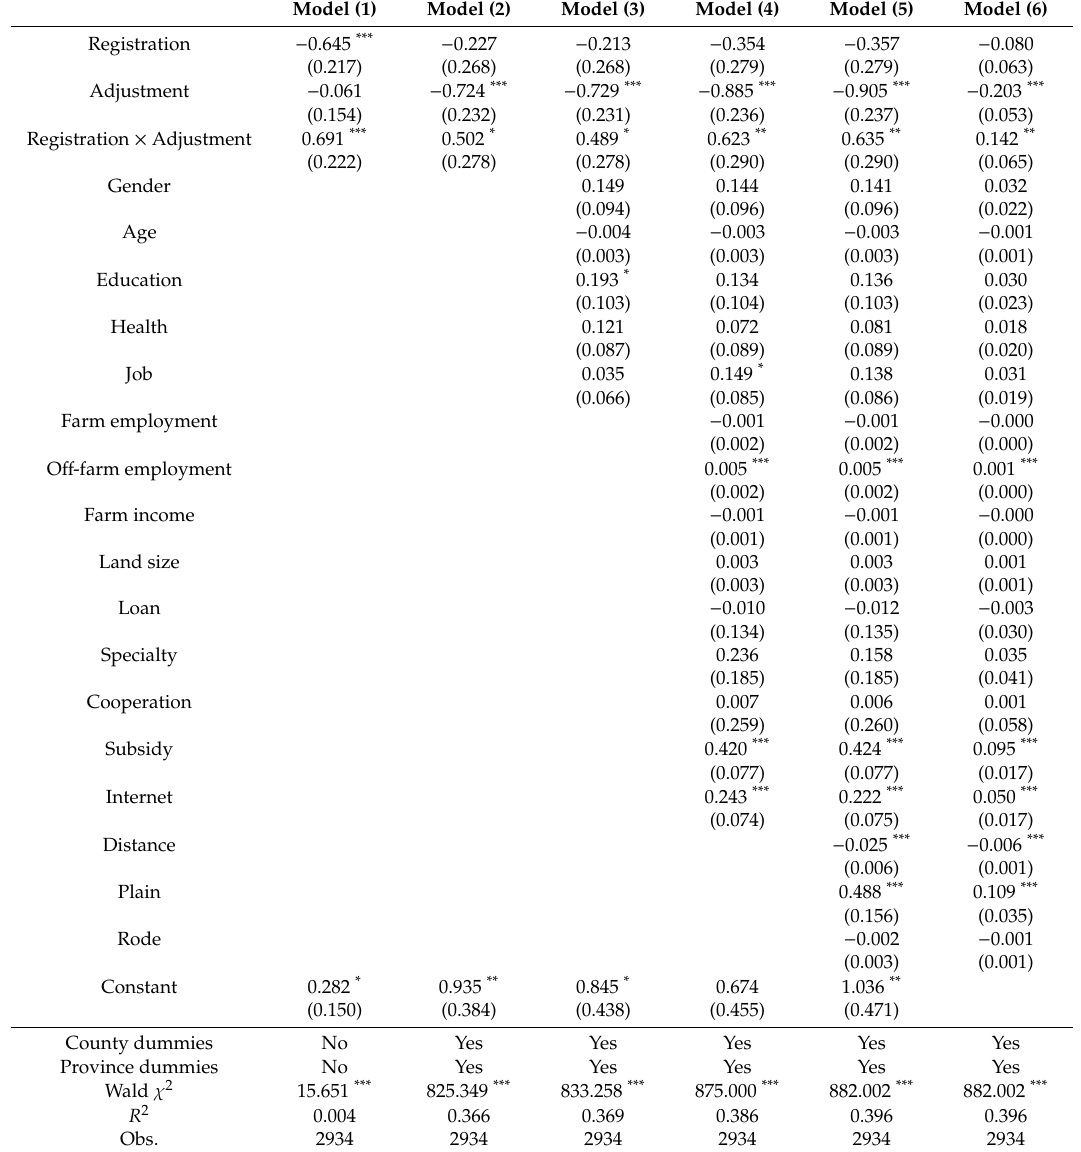
Table 2. The impact of registration and adjustment on the adoption of agricultural